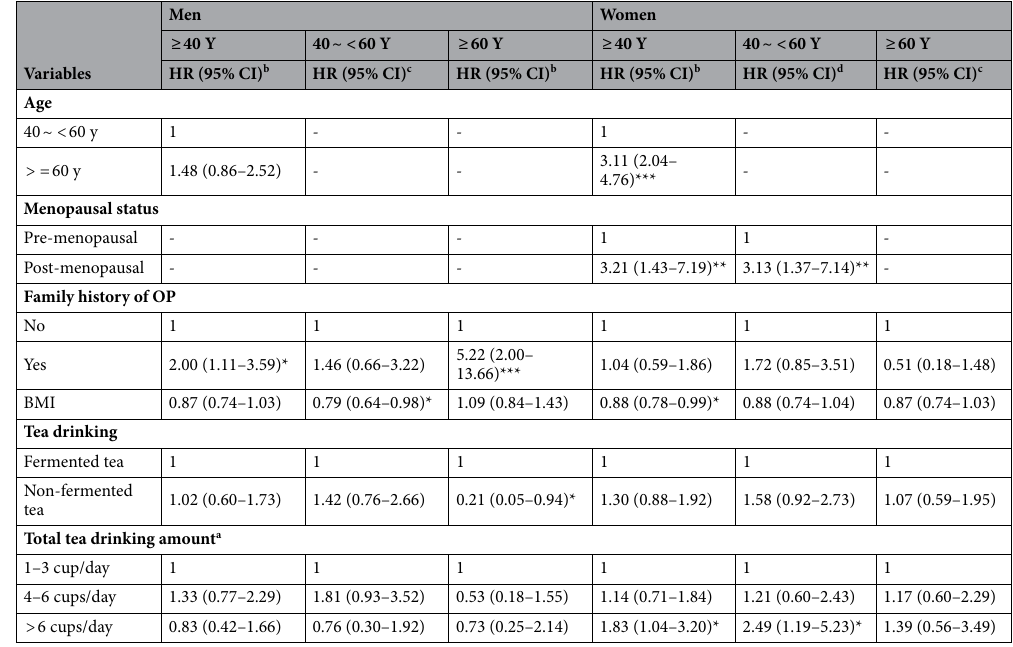
Table 3. Multivariate Cox proportional hazards regression model for osteoporosis by sex and age. Y, years old; CI, confidence interval; HR, hazard ratio; OP, osteoporosis; BMI, body mass index. p < 0.05*; p < 0.01**; p < 0.001***. a Total tea drinking amount was divided by cups (200 ml). b Hazard ratio adjusted for educational level, residential urbanicity, diabetes mellitus, coronary heart disease, waist circumference, hip circumference, coffee drinking habits, regular diet > 3 meals per day, regular exercise, smoking experience, weekday